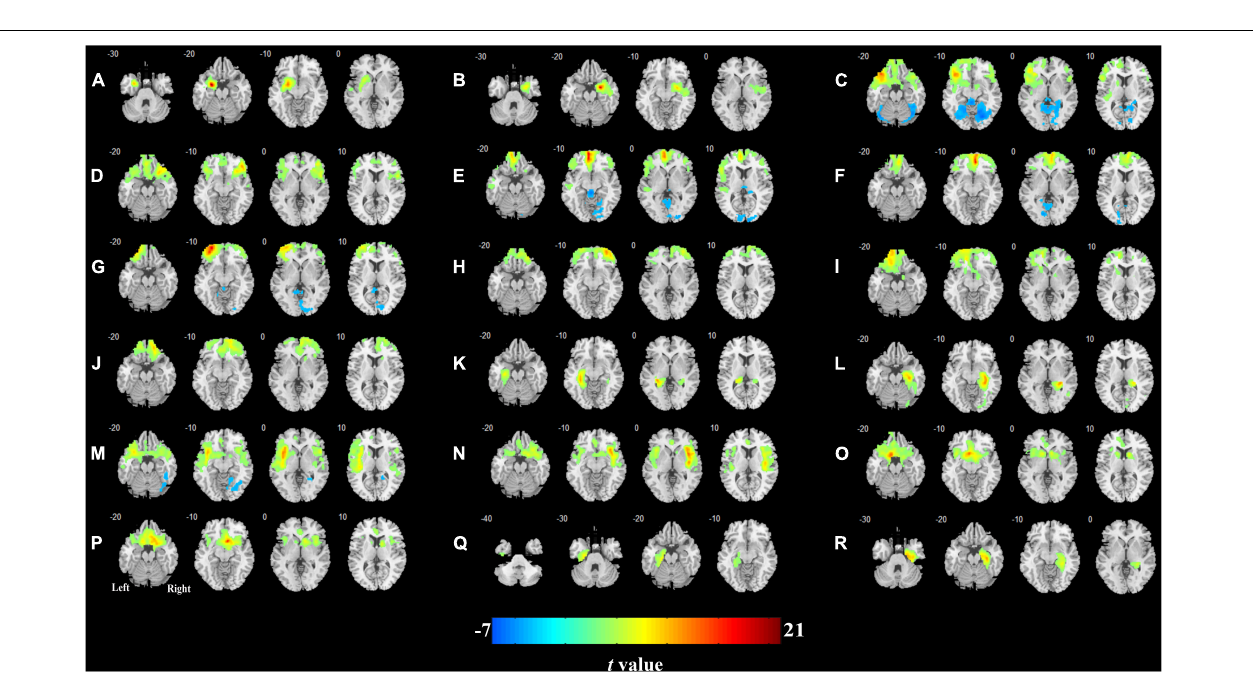
FIGURE 2 | Correlation of the CBF changes in olfactory brain regions with clinical parameters and neuropsychological tests in patients with T2DM (A–F) . SDS, Self-Rating Depression Scale; gluMax, max blood glucose; gluMean, mean blood glucose.